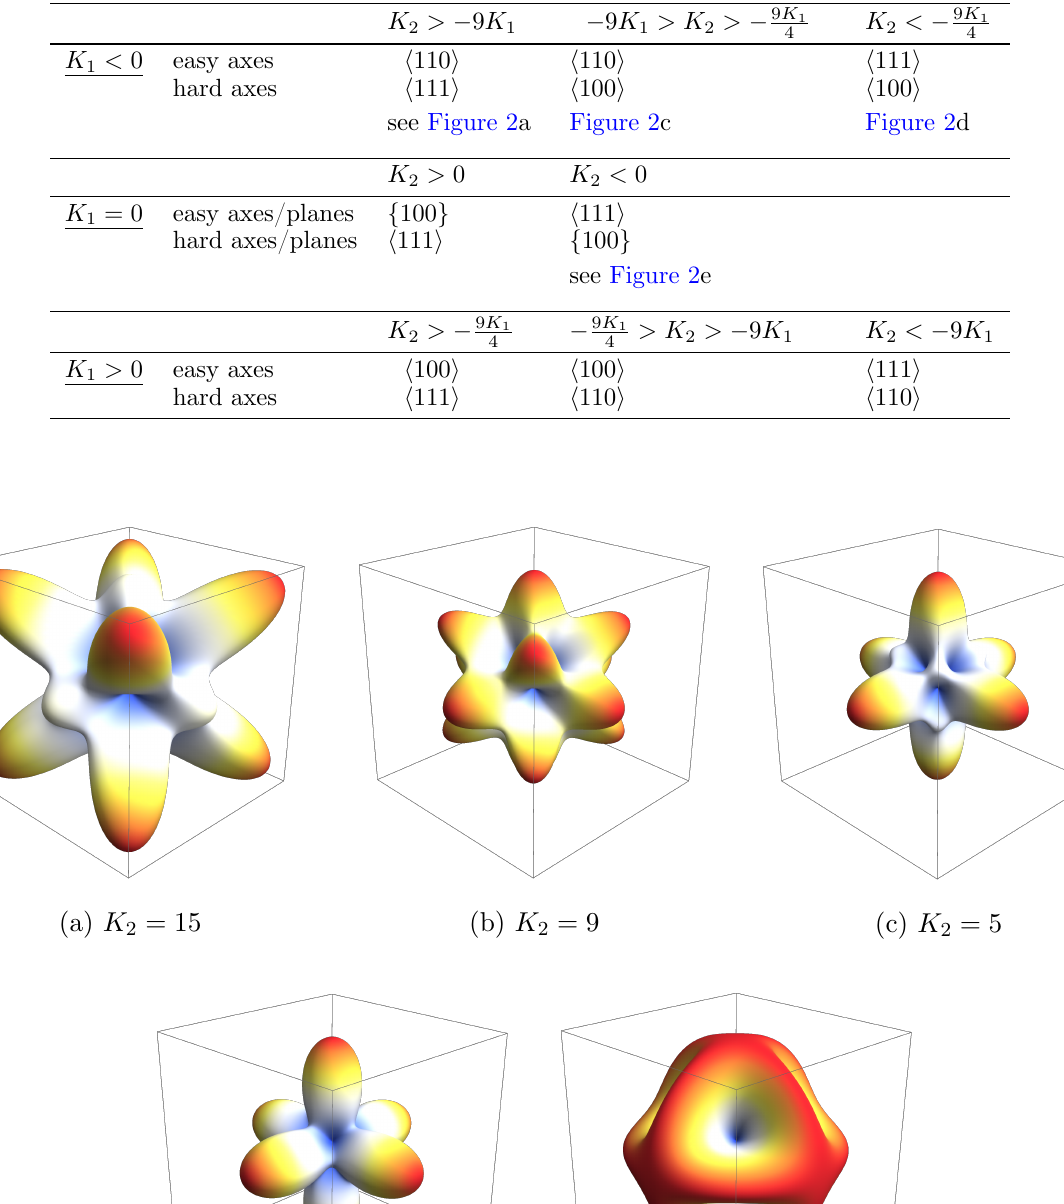
Table 1. Easy and hard axes for all combinations of K 1 , K 2 (except for the equality cases).